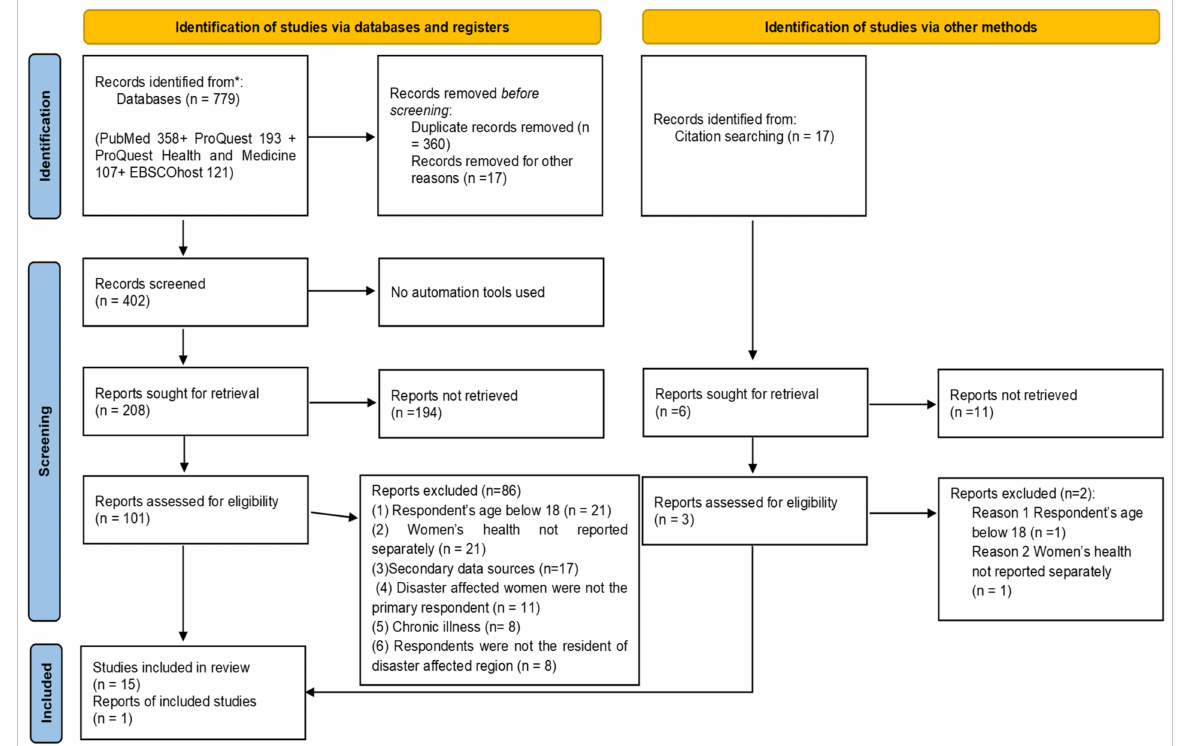
Figure 1. PRISMA flow diagram of included studies.* According to PRISMA * means: consider reporting the number of records identified from each database rather than the total number across all databases.